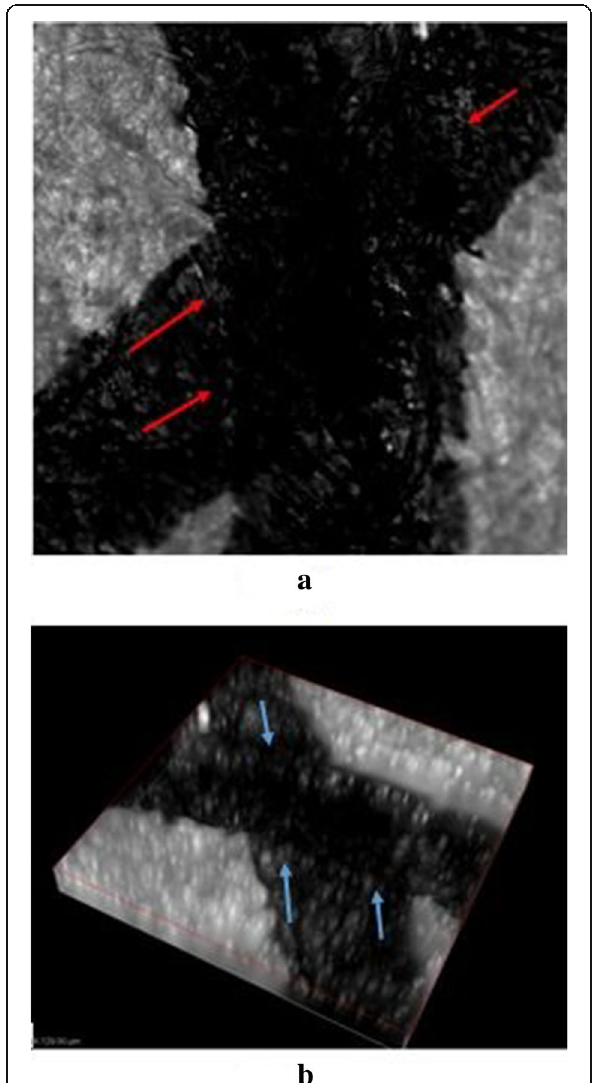
Fig. 6 Black Cello Butterflow pen intersecting strokes. a 2D figure.